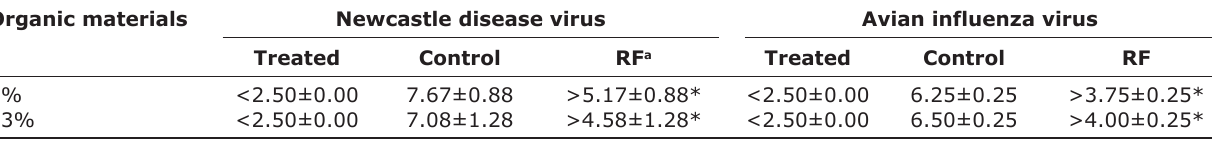
Table-1: The results are presented as log virus inactivating efficacy, using food additive grade calcium hydroxide powder, in the absence or presence of organic